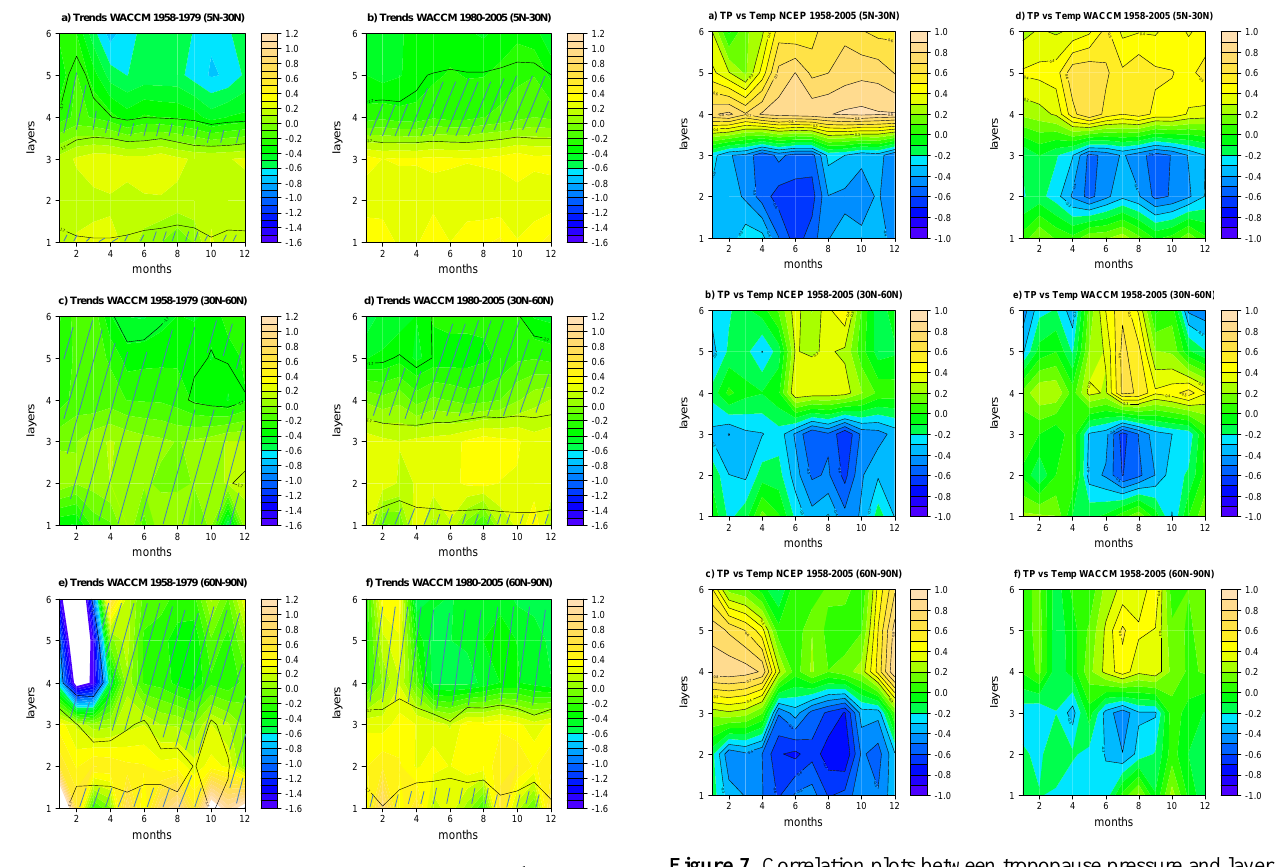
Figure 6 Figure 6. Layer mean temperature trends ( ◦ Cdecade − 1 ) for each month ( x axis) and layer ( y axis) based on WACCM model over the periods 1958–1979 and 1980–2005, respectively, for three lat- itudinal belts: (a) and (b) for 5–30 ◦ N, (c) and (d) for 30–60 ◦ N and (e) and (f) for 60–90 ◦ N. Layer 1: 1000–925hPa, Layer 2: 925–500hPa, Layer 3: 500–300hPa, Layer 4: 100–50hPa, Layer 5: 50–30hPa, and Layer 6: 30–10hPa. The shaded areas are non- statistically significant at the 90% confidence level.